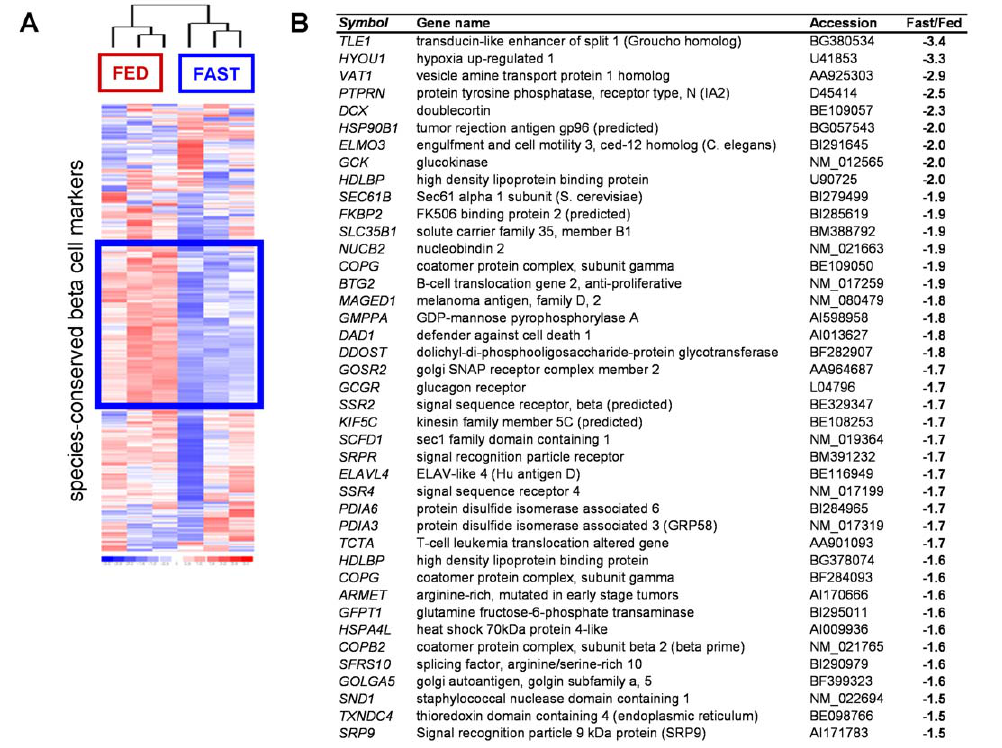
Figure 5. In rat beta cells fasting down-regulates cluster C genes with role in ER function and protein processing. Heat map in Fig. 5A shows the complete set of species-conserved beta cell markers, visualized in FACS-purified beta cells freshly isolated from control (FED) and 24-h fasted (FAST) rats; one third is reproducibly $ 1.25-times down-regulated (blue window) most of which statistically significantly (21% of all beta markers, p , 0.05, n=3). Table in panel B shows the 42 beta markers that are at least 1.5-fold down-regulated (p , 0.05) by fasting: 50% of the fasting- suppressed beta cell marker genes belong to cluster C, also functionally enriched in pathways of protein folding and processing through ER/Golgi.